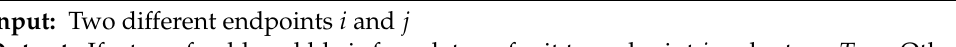
Algorithm 3 depth _ f irst _ search ( i , j